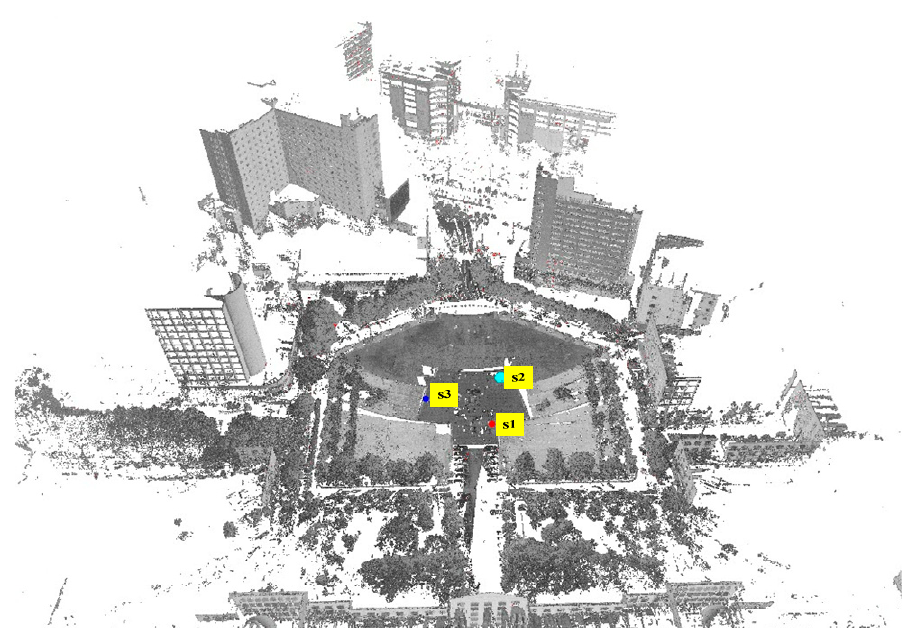
Figure 7. View of data set 1 after registration and three scan positions. Table 1. Basic information of each scan.